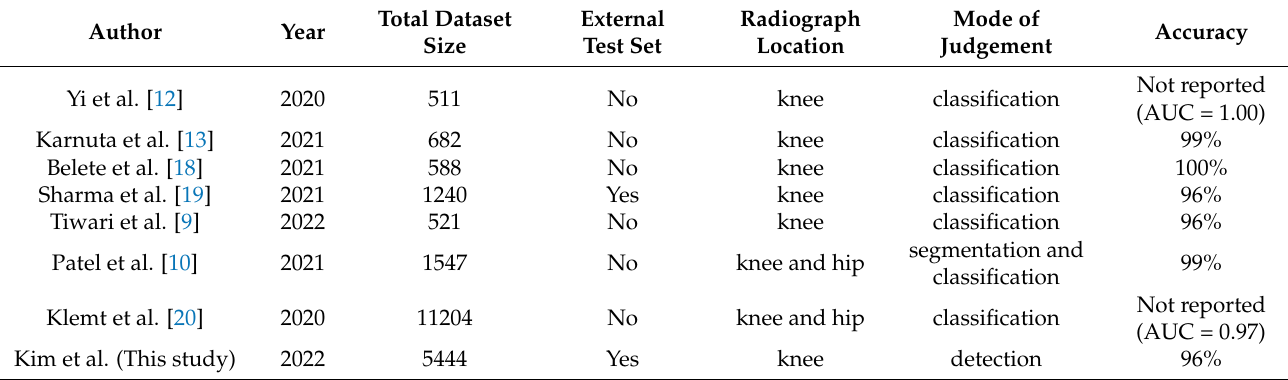
Table 5. Comparison with previous